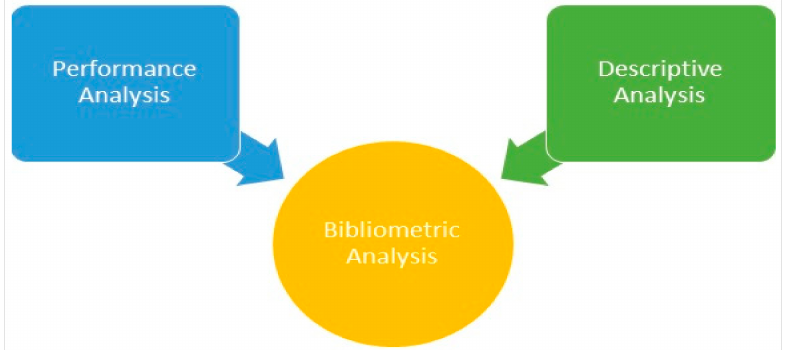
Figure 4. Bibliometric analysis: aspects.